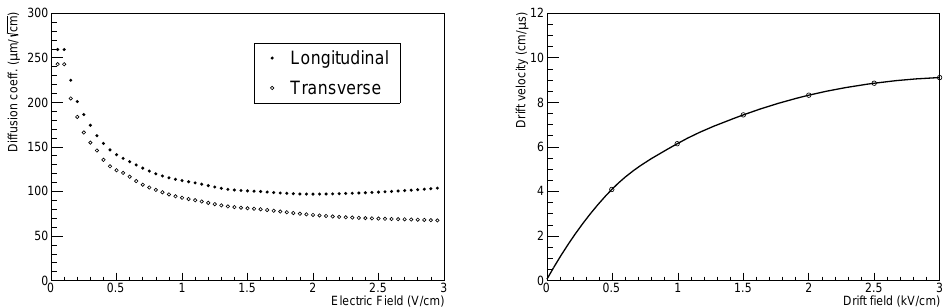
Figure 1. Transverse and longitudinal diffusion coefficients for He/CF 4 60/40 ( left ) and electron drift velocity as a function of the drift field ( right